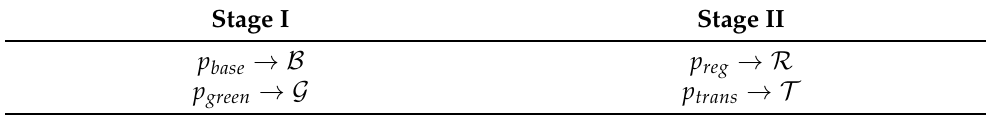
Table 5. Formula symbols for